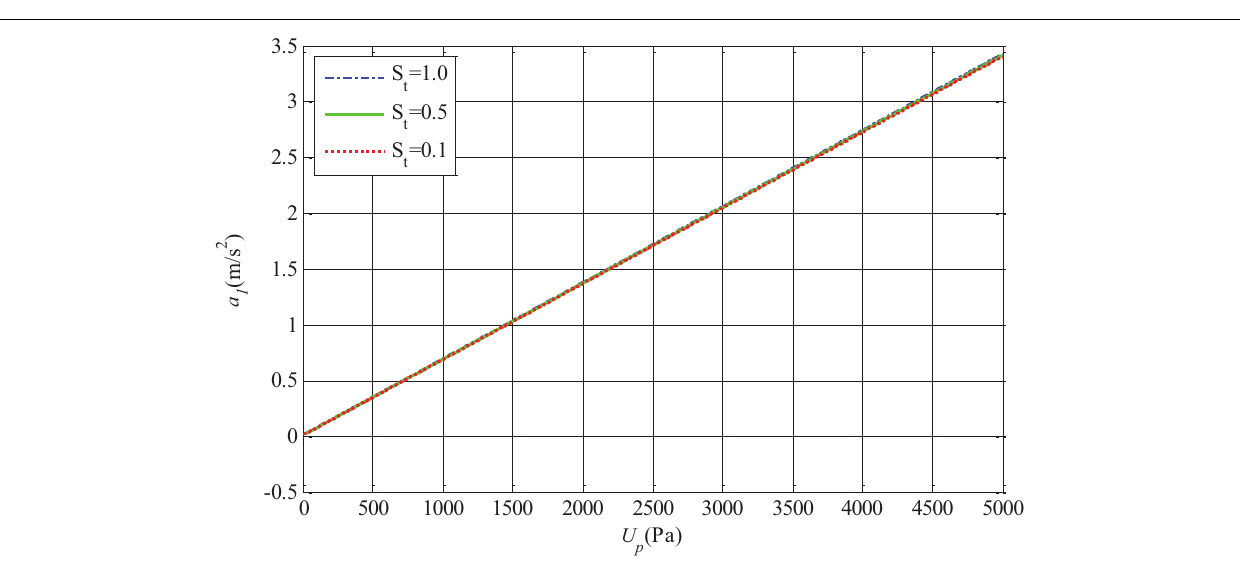
FIGURE 9 | Relationship between velocity and pore water pressure in flow with overlying layer.